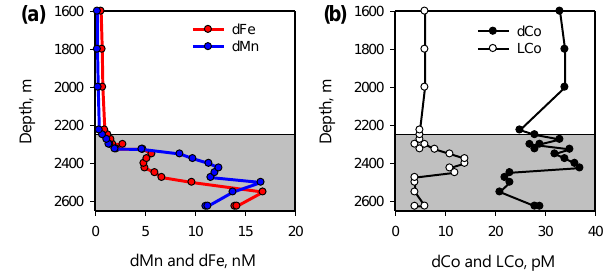
Figure 12. Profiles from Station 18 at the East Pacific Rise ridge crest at 113 ◦ W, 15 ◦ S. (a) dMn (blue lines) and dFe profiles (red) replotted from Resing et al. (2015) clearly show hydrothermal in- put. Grey shading below 2250m indicates area of hydrothermal in- fluence where dFe and dMn are >1nM. (b) Dissolved cobalt (dCo, black circles) and labile cobalt (LCo, white) in the East Pacific Rise hydrothermal